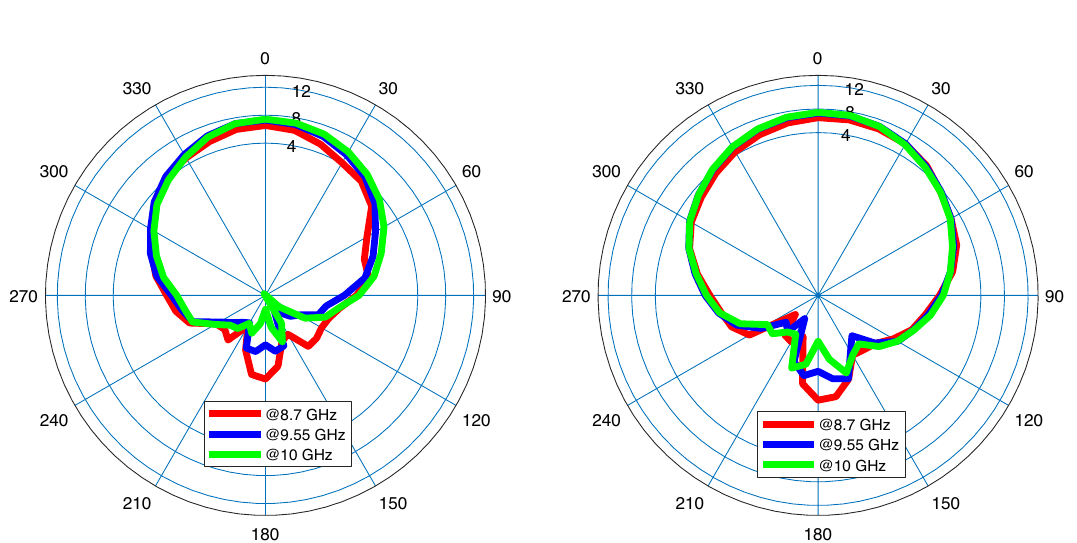
Figure 10. Radiation pattern of simulation antenna-1 at f 1 = 8.7 GHz (red), f 2 = 9.55 GHz (blue), and f 3 = 10 GHz (green); φ = 0 (left), φ = 90 ◦